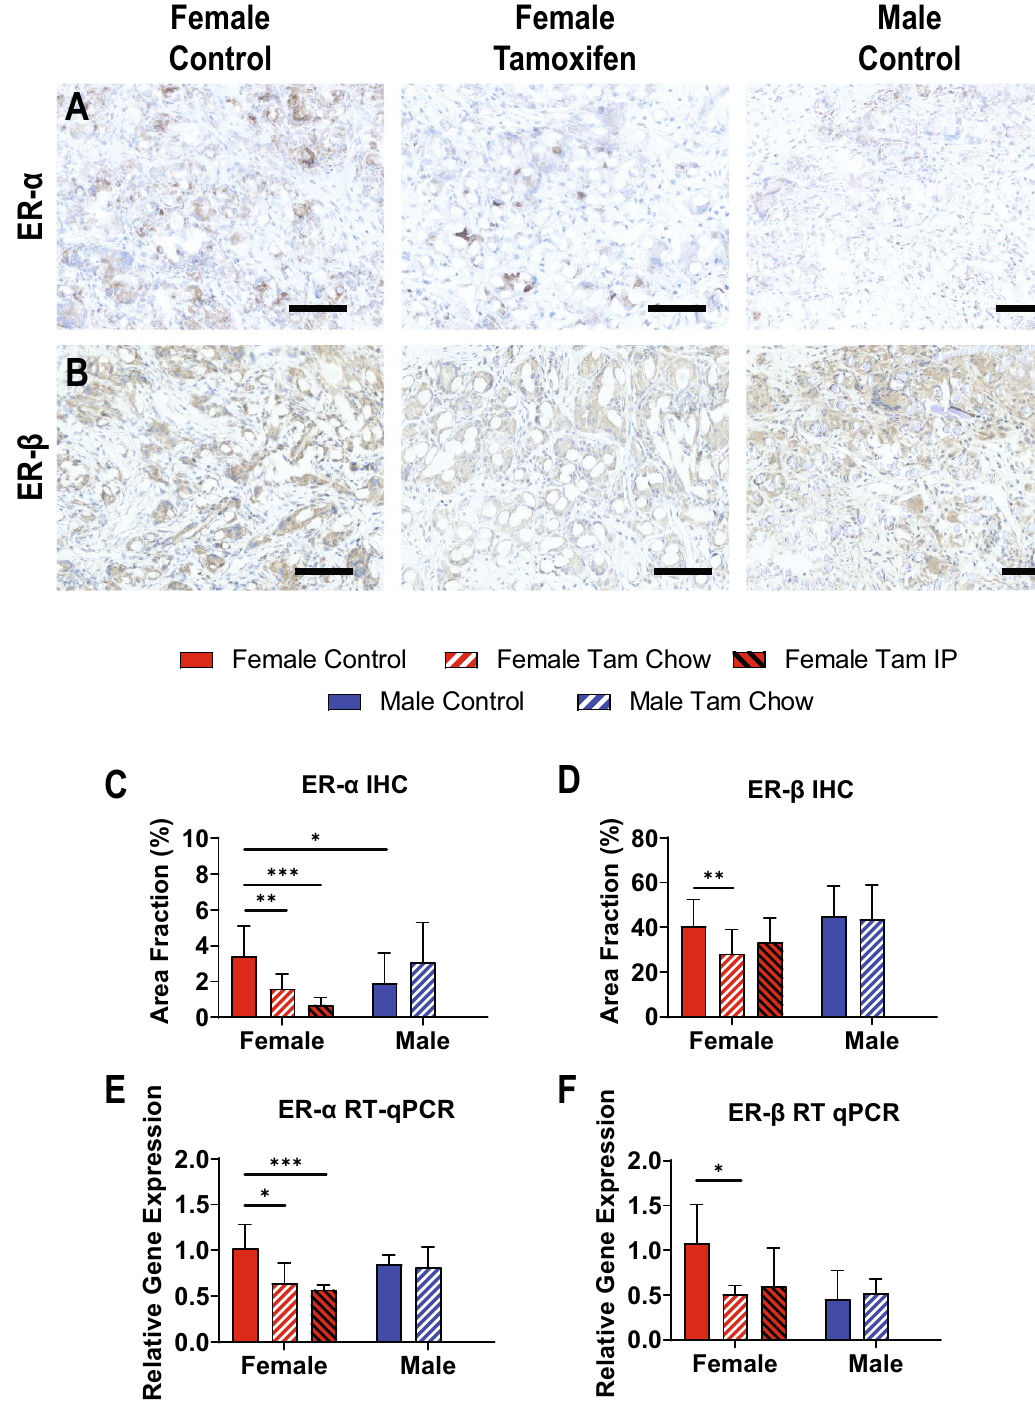
Figure 3. Estrogen Receptors Downregulated by Tamoxifen. Representative IHC of ER-α ( A ) and ER-β ( B ). IHC quantifications of ER-α ( C ) and ER-β ( D ). RT-qPCR analysis of ER-α ( E ) and ER-β ( F ). N = 15–20 for histology measures ( C , D ), and N = 6 for RT-qPCR measures ( E , F ), all compared using t-tests. Scale bars = 200 µm p < 0.05, ** p < 0.01, *** p <